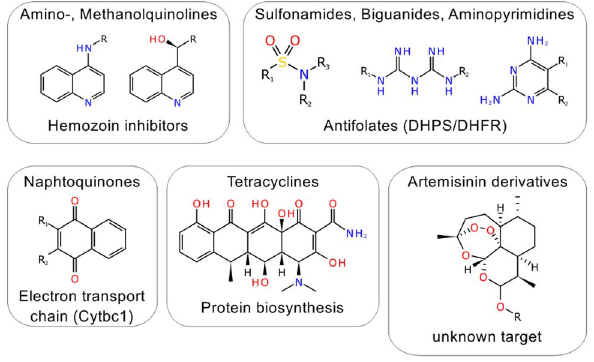
Figure 1. Clinically used antimalarial chemotypes and their corresponding